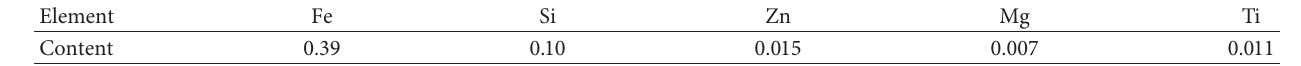
Table 1: Chemical composition of the TRC and HR sheets for foils (wt.%).